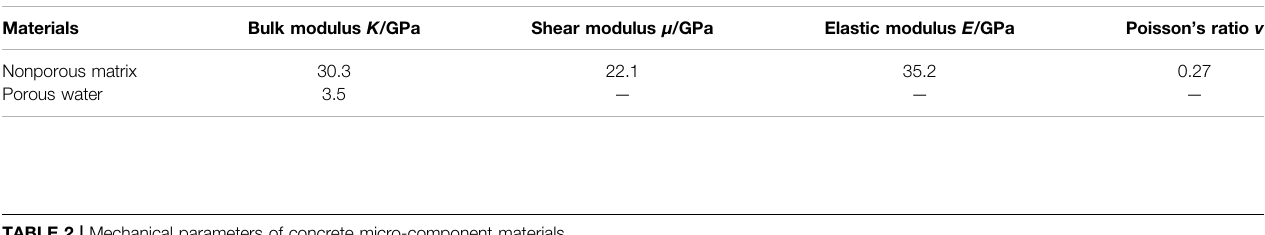
TABLE 1 | Mechanical parameters of materials.